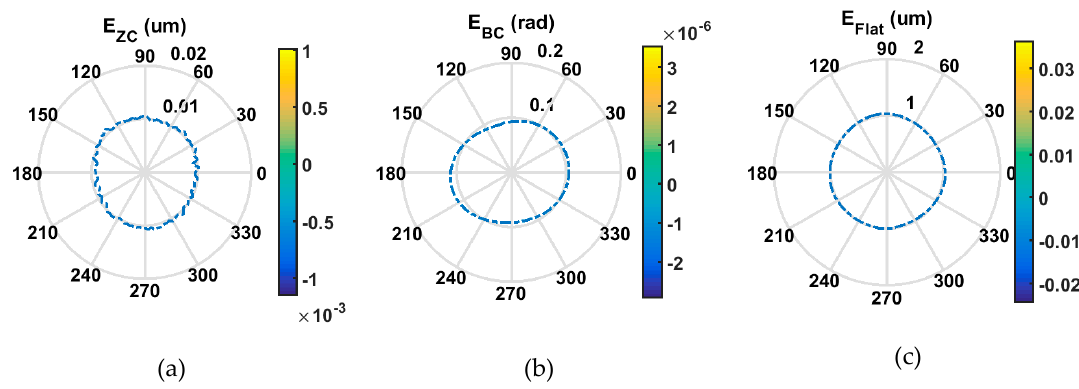
Figure 11. Error separation of C axis axial error E ZC , tilt error E BC , and artefact profile error E flat . ( a ) Axial error E ZC , ( b ) Tilt error E BC , ( c ) Artefact profile error E flat .